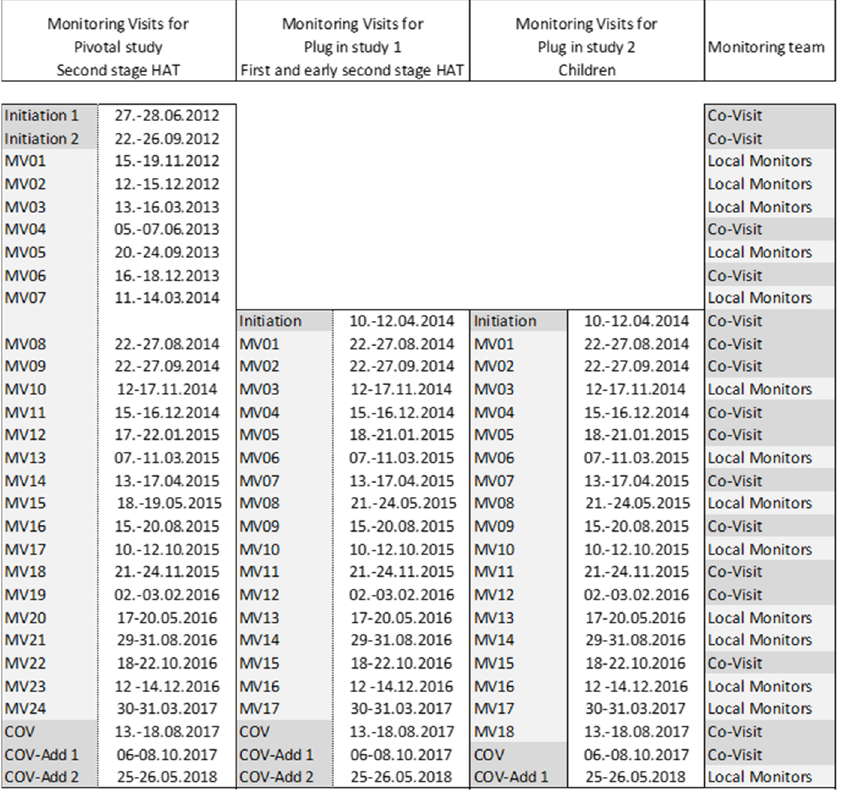
Figure 6. Example of a monitoring visit schedule for one of the high-recruiting study sites (MV, monitoring visit; COV, close out visit; Add, additional visit). monitoring visit; COV, close out visit; Add, additional